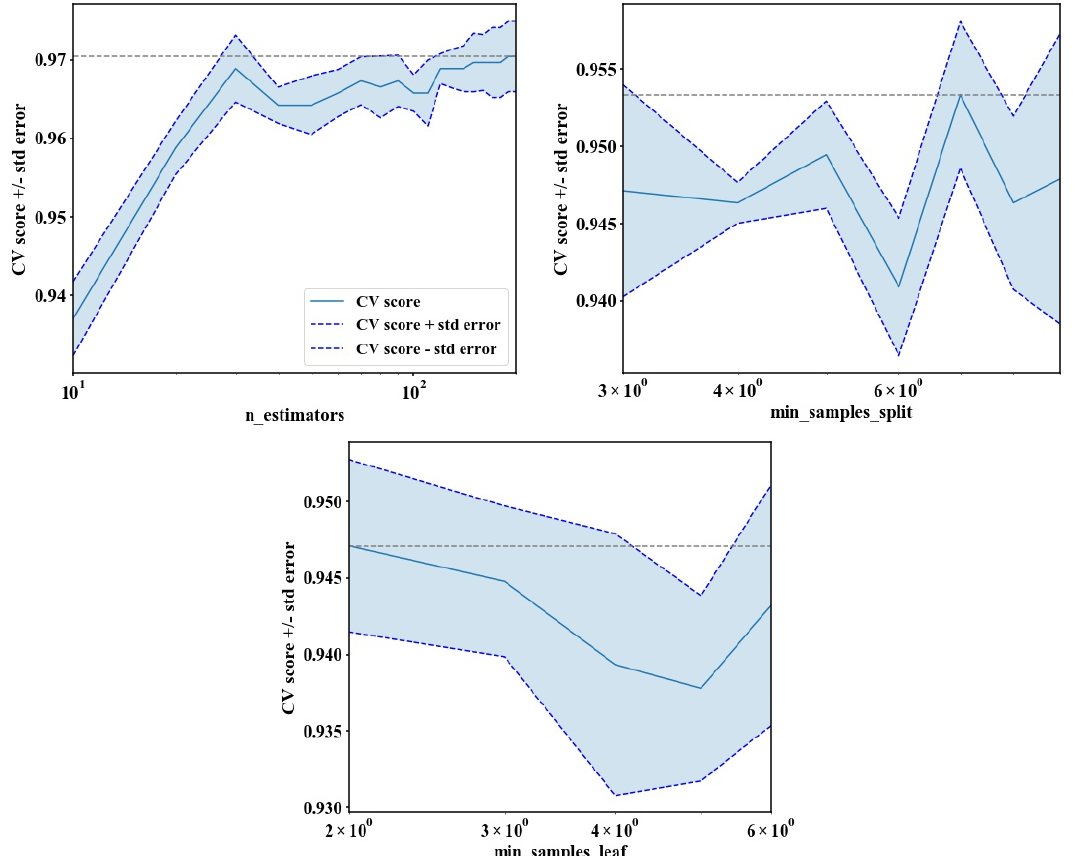
Figure 7. The assessment results under different parameter values.